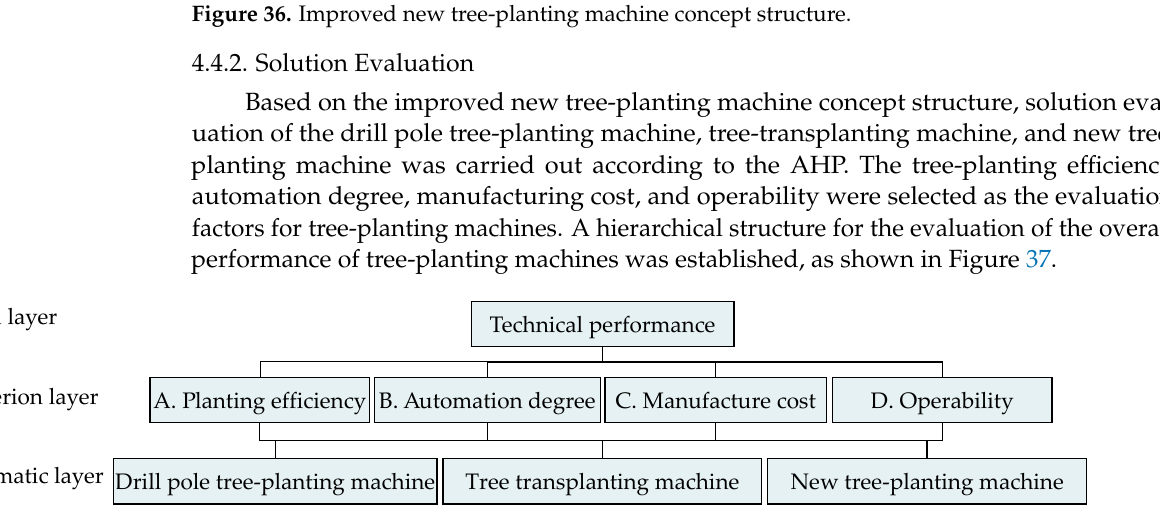
Figure 37. Hierarchical structure for the evaluation of the overall performance of tree-planting ma- chines.